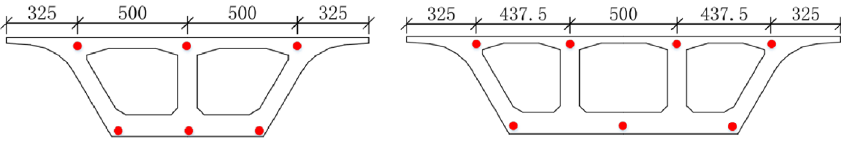
(a) Lateral arrangement of stress observation points of box girder